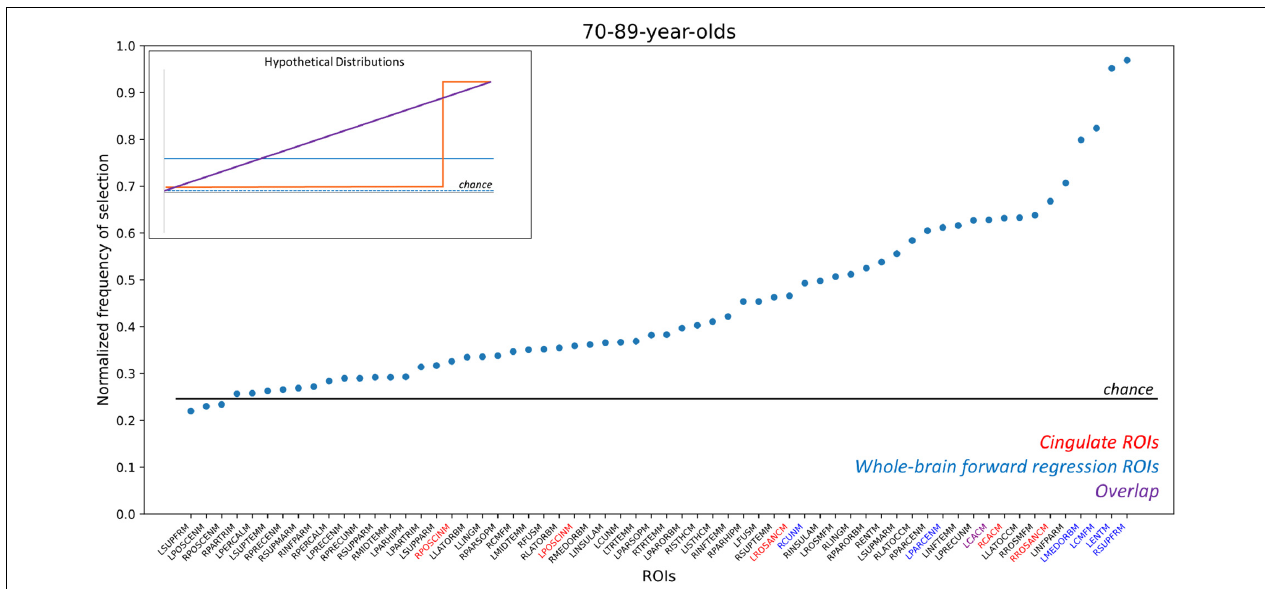
FIGURE 4 | Frequency of ROI selection in bootstrapping analysis. Random samplings of subjects matching our existing TCP rates were repeatedly drawn and analyzed using the same logistic forward regression to determine how often each ROI was selected by the model. ROIs here are sorted by their frequency of being selected, which was normalized by the number of iterations ( n = 1,000) to scale from 0 to 1, and ROI names are color-coded by whether they are part of the cingulate (red) , were in the original whole-brain model (blue) , or both (purple) . The horizontal line reflects the chance frequency of selection. ROI names are based on NACC labels. RPOSCINM, Right Posterior Cingulate; LPOSCINM, Left Posterior Cingulate; LROSANCM, Left Rostral Anterior Cingulate; RCUNM, Right Cuneus; LPARCENM, Left Paracentral; LCACM, Left Caudal Anterior Cingulate; RCACM, Right Caudal Anterior Cingulate; RROSANCM, Right Rostral Anterior Cingulate; LMEDORBM, Left Medial Orbital; LCMFM, Left Caudal Middle Frontal; LENTM, Left Entorhinal; RSUPFRM; Right Superior Frontal. For full list, please refer to NACC’s Imaging Data Researcher’s data dictionary: https://files.alz.washington.edu/documentation/rdd-imaging.pdf. Inset figure: Hypothetical distributions that would arise from different underlying models: (orange) distribution that would result if only a small subset of regions were highly predictive; (purple) distribution that would result if an even gradient of predictive ability existed across regions; (blue, dashed) distribution that would result if no regions’ cortical thickness could model TCP status; (blue, solid) distribution that would result if all regions had some predictive power but there was no differentiation across